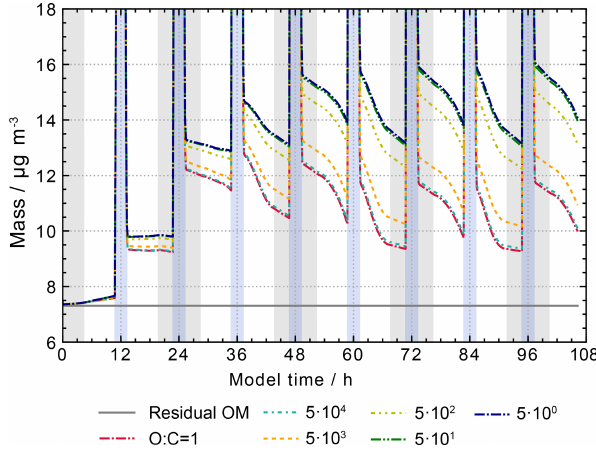
Figure 16. Processing of the organic mass fraction in the sensi- tivity runs investigating the influence of alkoxy radical chemistry on aqueous-phase chemistry and composition using the same con- ditions as in the scenario with O : C = 1 but varying the mono- molecular decay rate of alkoxy radicals as given in the figure legend as per second (s − 1 ) . Cloud passages are shaded blue and night-time periods are shaded